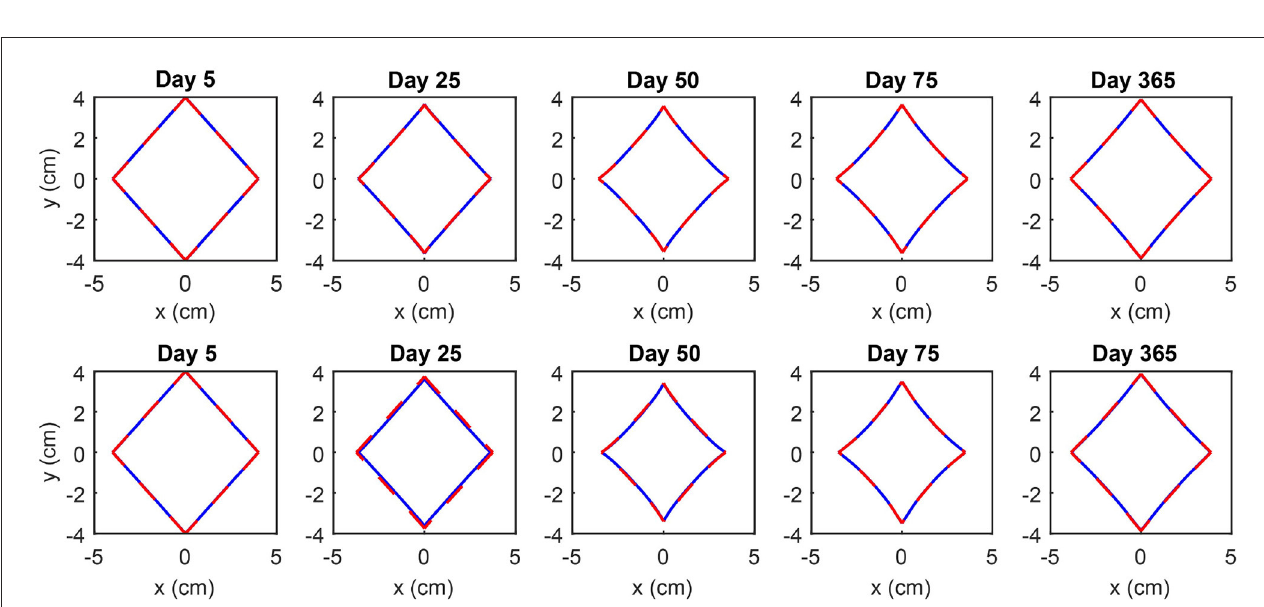
FIGURE4 Results from the neural network for the wound/scar edge. The upper graphs show the best predictions, while the lower graphs show the worst ones. In each graph, the blue line shows the target, and the red dashed line shows the neural network prediction.